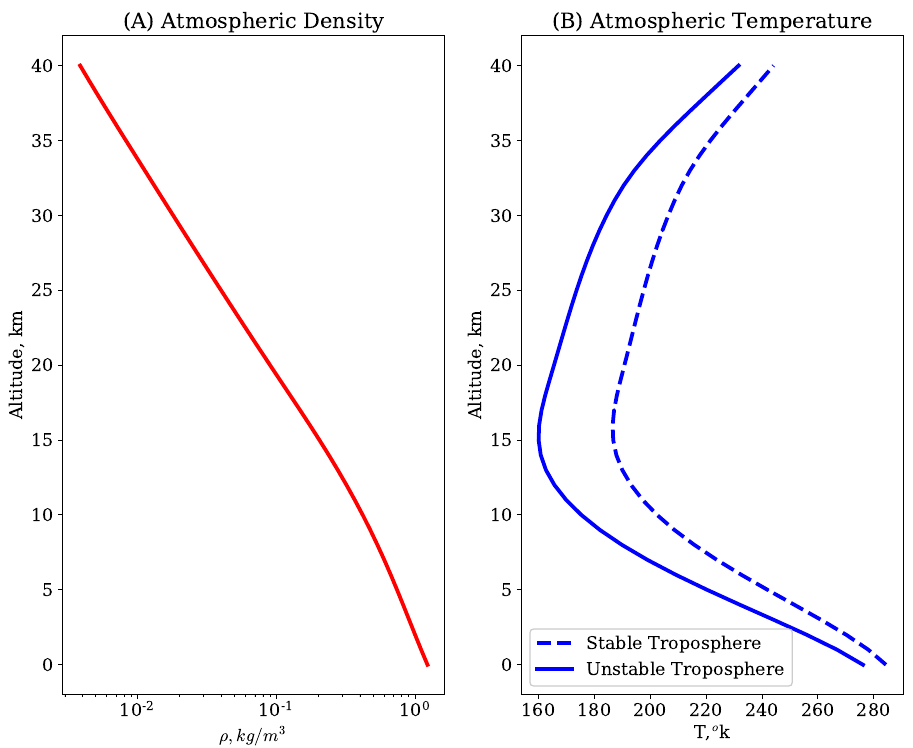
Figure 2. Ambient conditions derived from the NRLMSISE model. In ( A , B ), atmospheric density and temperature are shown. Two temperature profiles represent covectively stable and unstable